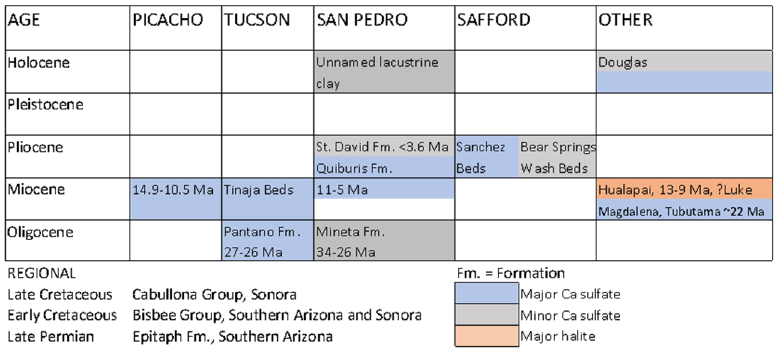
Figure 1. Map of southwest North America, showing locations mentioned in the paper relative to zones of porphyry copper mineralization. A = Animas Playa; B = Bristol Lake; C = Cascabel; Ch = Chandler Basin; D = Douglas; E = Estancia Basin; FQ = Fort Quitman; Hu = Hualapai Basin; LBH = Luke Basin halite; Ma = Mammoth; Mg = Magdalena; Ms = Marsh Station; P = Picacho Basin; PG = Playa Guzman; S = Safford Basin; SD = Saint David; SS = Salton Sea; Tp = Tucson Basin, Pantano Formation; Tt = Tucson Basin, Tinaja Beds; W = Willcox Playa; WS = White Sands dune field; Wh = Whetstone Mountains. Details of sample locations in the Safford and Tucson Basins and at Douglas are given in Supplementary Figures S1–S3.